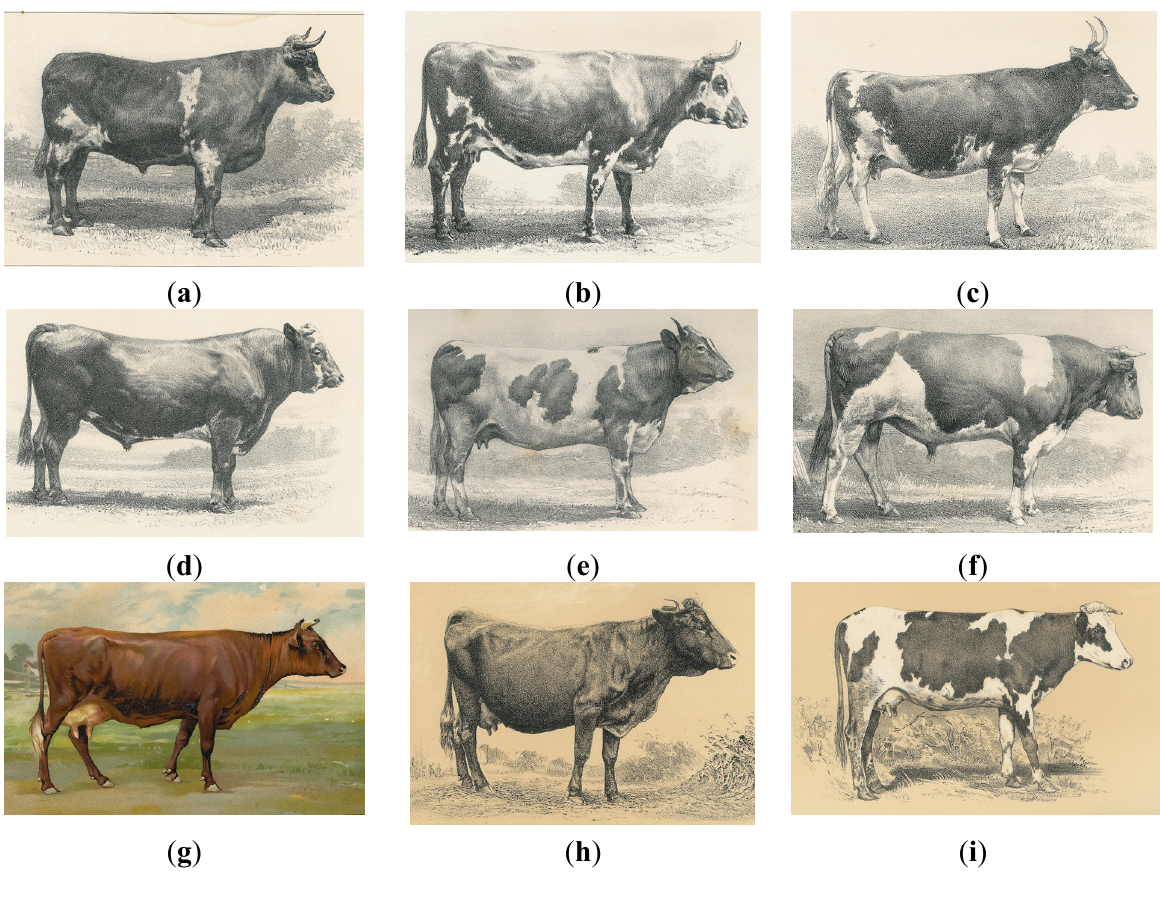
Figure 15. European continental dairy and dual-purpose breeds in the 19th